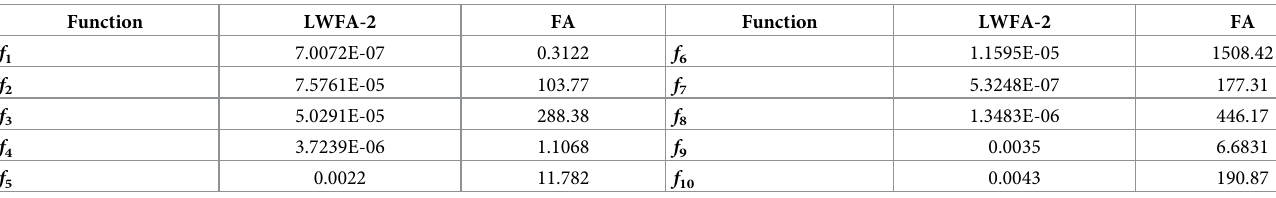
Table 2. The comparison results of LWFA-2 and FA with D = 30.